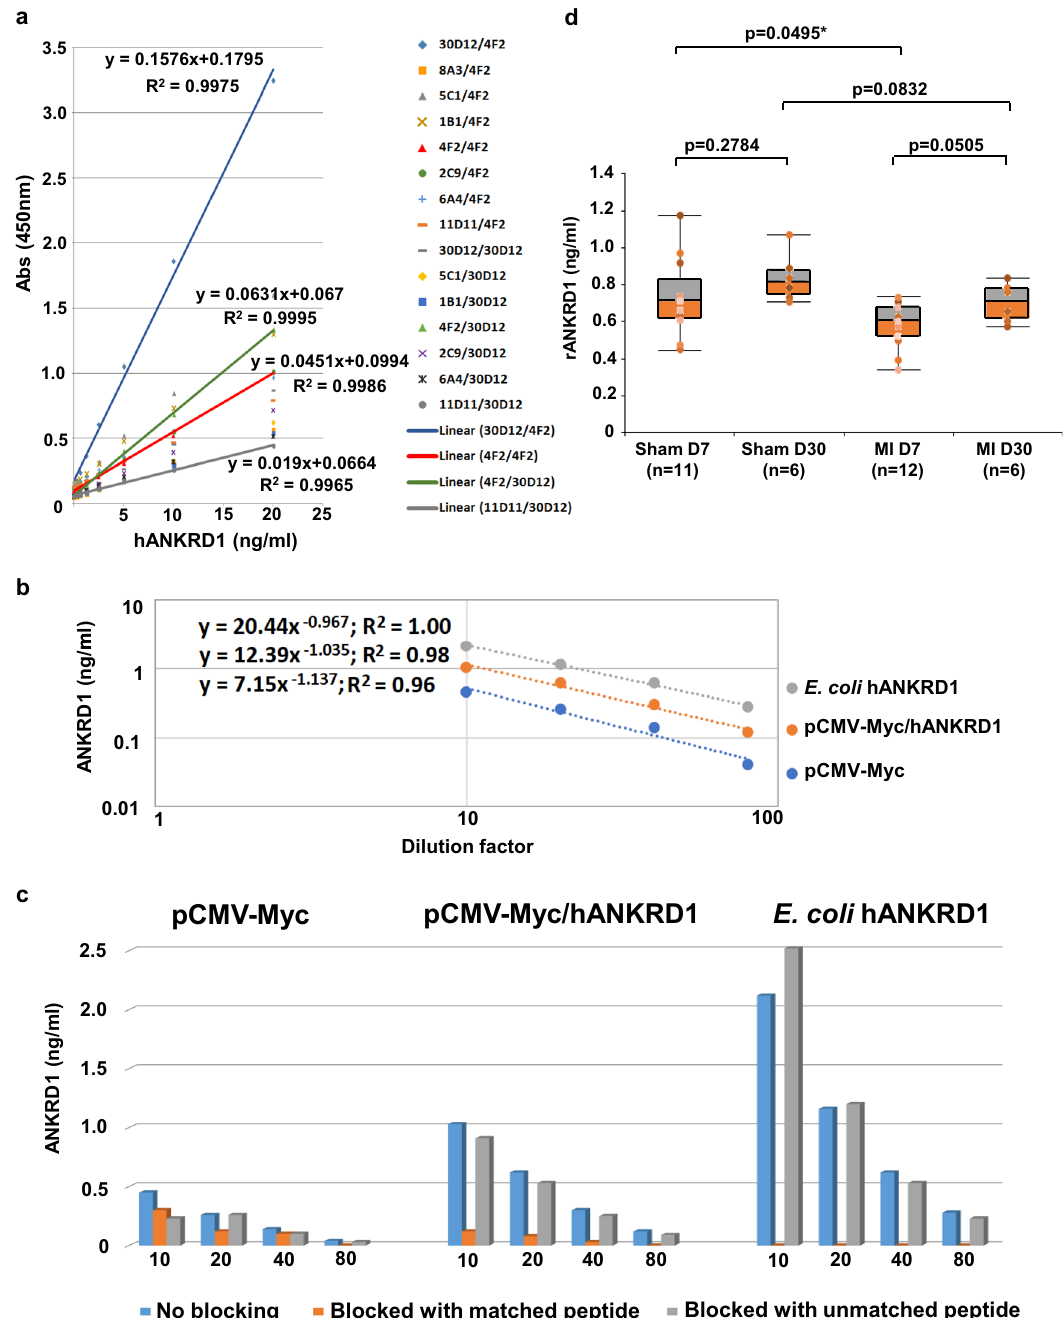
Fig. 4 Antibody validation by ELISA. a Antibody-pair dose response against recombinant hANKRD1 (OriGene Technologies). The legend lists each capture/detection antibody matched pair used. A linear curve fi t over analyte concentration ranging from 0.313 – 20 ng/ml is applied to representative antibody pairs. b Dilution curves ( fi tted with power-law regression where the exponent of function x represents the slope of the curve) of endogenous rANKRD1 and ectopic Myc-hANKRD1 present in transfected H9c2 lysate and hANKRD1 from induced E. coli cells. Data points represent 10, 20, 40 and 80 fold dilution of cell lysates with starting total protein concentration at ~2 mg/ml. Both axes are plotted in the log10 scale for better visualization of parallelism. c Effect of peptide competition in ELISA where the detection antibody is blocked by matched or unmatched peptides. Data from 10, 20, 40 and 80 fold diluted lysates are shown. d Plasma rANKRD1 concentration (ng/ml) in experimental MI and Sham rat on days 7 (D7) and 30 (D30). The boxplot represents data quartiles (25th, median and 75th percentile) and error bars represent the maximum and minimum data values. Data distribution for each boxplot is indicated by the coloured dots. Two-tailed unpaired t -test was used to compare each two-group combination with signi fi cance at p < 0.05. n number of individual animals in each